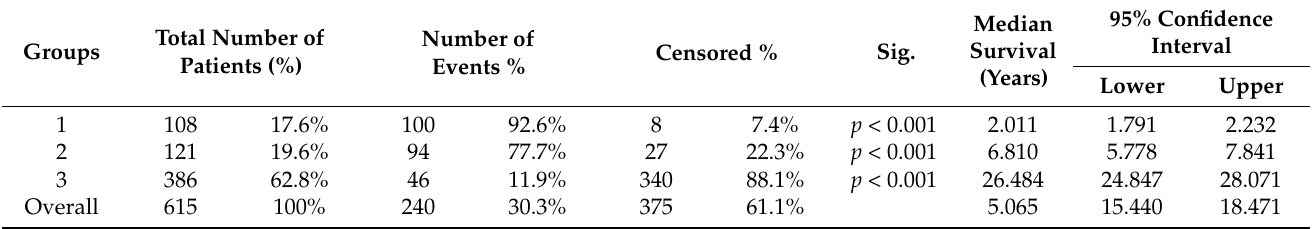
Table 3. Grouping of the 615 UM patients based on survival ≤ 2 years, between 2-3 years and >3 years of onset of metastasis